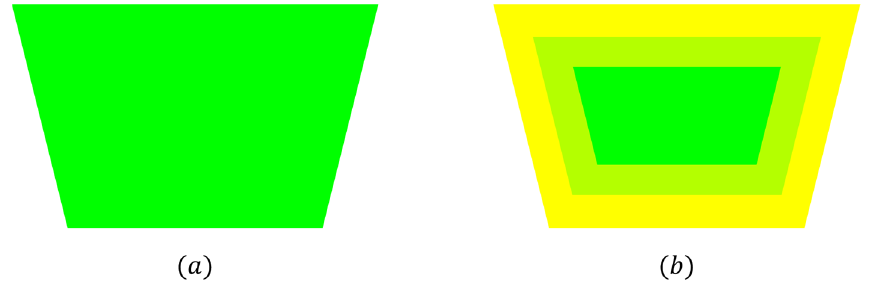
Figure 1. Graded coverage valuation modeled as: ( a ) bivalent function, ( b ) real-valued